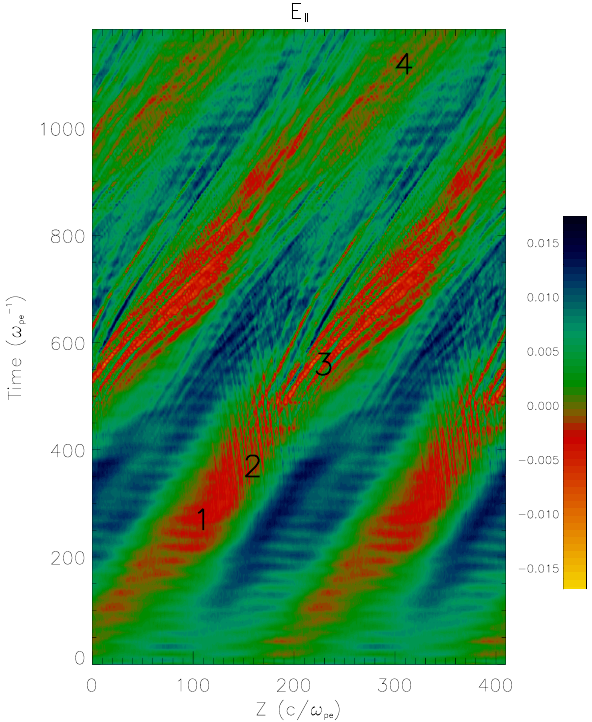
Fig. 2. Time evolution of the parallel electric field averaged on the density gradient (large amplitude case, δB/B = 0 . 05). Two pe- riodic simulation boxes have been piled up to reveal the formation of small-scale structures. Labels 1–4 correspond to the predomi- nance of: the large-scale field (1), the Buneman instability (2), the beam-plasma instability (3), the large-scale field again (4).